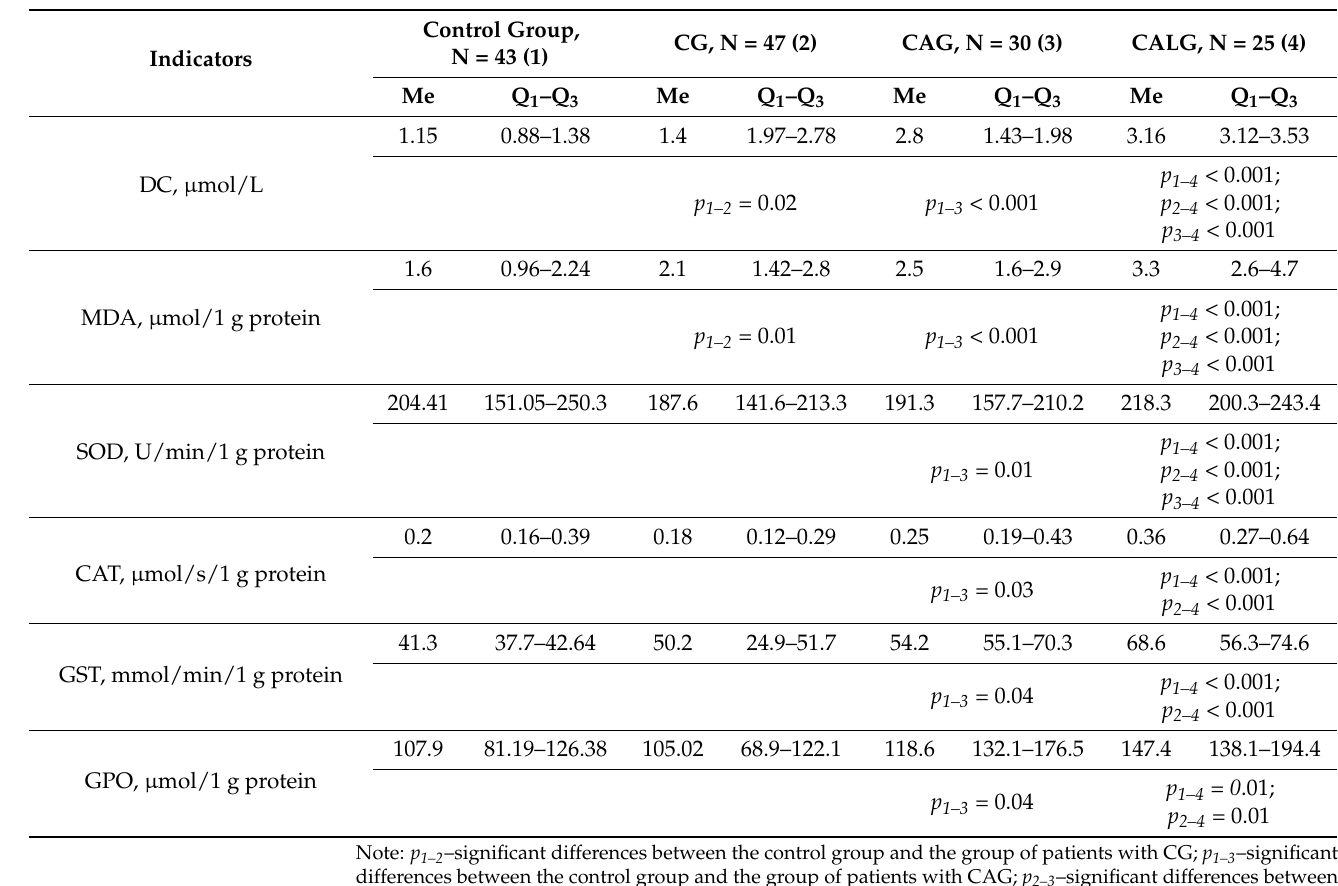
Table 4. Characteristics of LPO–AOD system indicators in various types of chronic gastritis with serum response against H. pylori as “IgG >